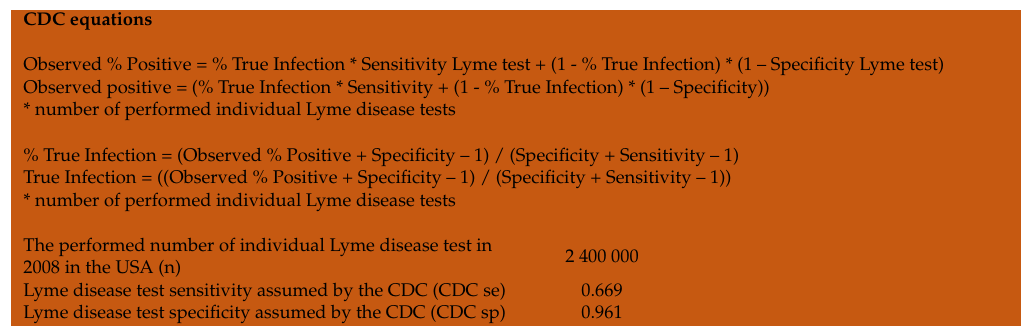
Table 6. Comparison 1 of the CDC model and my Lyme disease